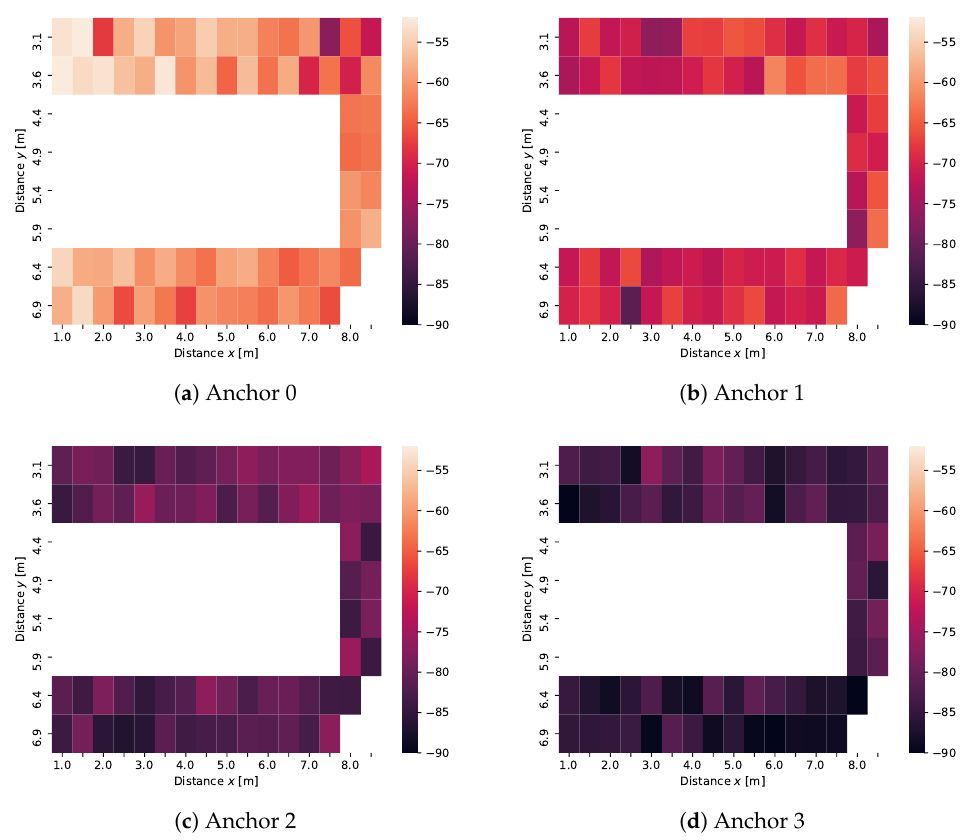
Figure 15. Mean values of received signal strengths (RSSs) at four anchor location when the transmit- ter is the moving tag in a two-dimensional position grid. All values (see legends) are in units dBm. For each location, the mean of all received measurement samples is displayed, Channel 37.